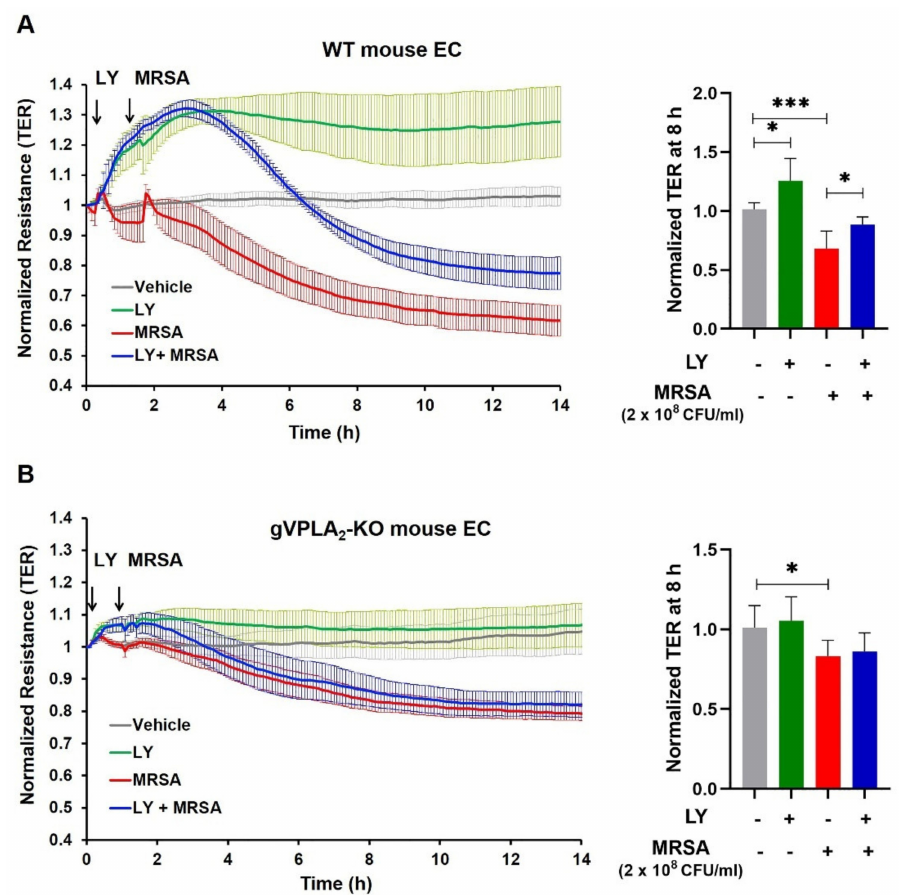
Figure 4. Effects of sPLA 2 inhibitor, LY311727, on HK-MRSA-induced EC barrier disruption in wild- type and gVPLA 2 -deficient mPVEC. ( A ): Wild-type (WT) or ( B ): gVPLA 2 -deficient (KO) mPVEC (isolated murine pulmonary endothelial cells) were pretreated with LY311727 (100 µ M, 1 h) and then challenged with HK-MRSA (2 × 10 8 CFU/mL). Depicted are pooled ECIS tracings (left panels) and normalized TER values at 8-h time point (right panels). * p < 0.05, *** p < 0.001. n =